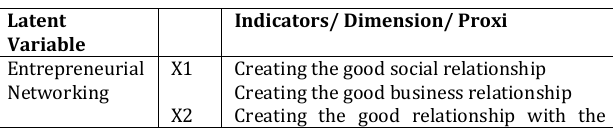
Table 3: Variables And